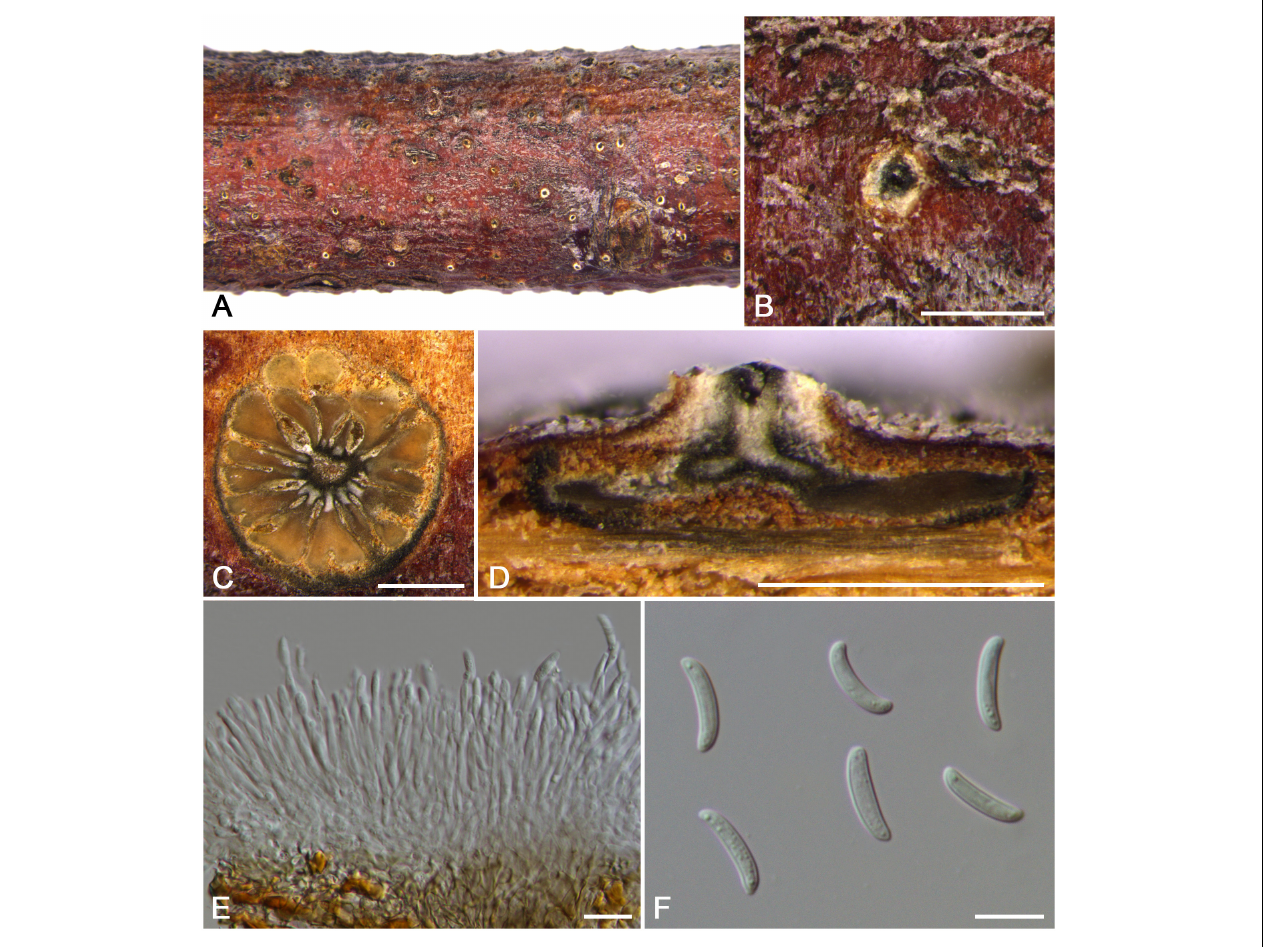
FIGURE 5 | Morphology of Cytospora cotoneastricola from Cotoneaster sp. (CF 20197031). (A,B) Habit of conidiomata on twig. (C) Transverse section of conidioma. (D) Longitudinal section through conidioma. (E) Conidiophores and conidiogenous cells. (F) Conidia. Bars: (B–D) = 500 µ m; (E , F) = 10 µ m.